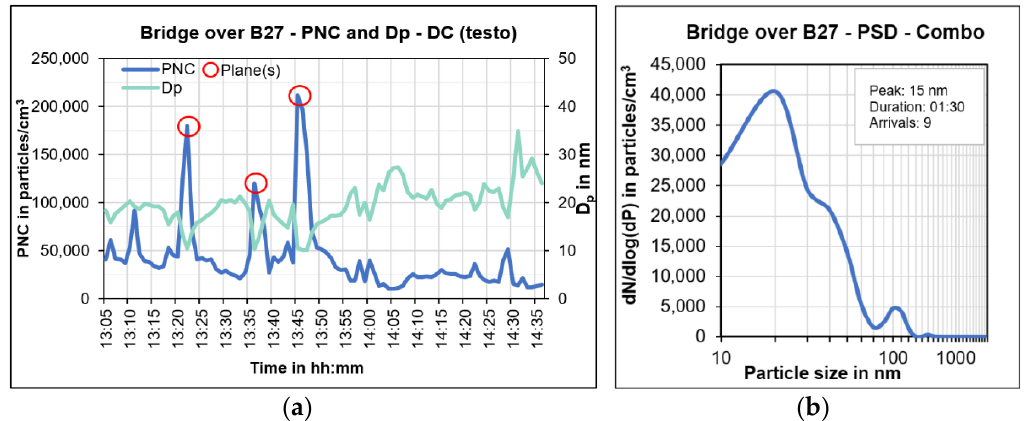
Figure 25. Freeway measurement results for ( a ) UFP PNC and D p from DC DiSCmini (testo) and ( b ) PSD combination.